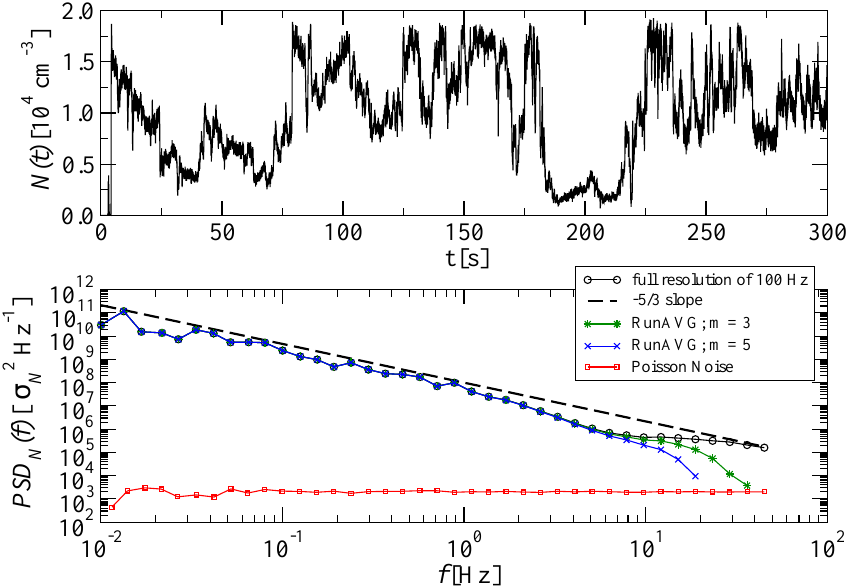
Fig. 10. The upper panel shows a 300-s long time series recorded under undisturbed atmospheric conditions. The FCPC was located about 1ma.g.l. (above ground level). The lower panel shows corresponding power spectral density functions using the full resolution (black curve), a running mean over 3 values (green curve) and a running mean over 5 values (blue curve). The red curve shows the spectral density of Poisson distributed data resulting in white noise (flat line). The black dashed line indicates a − 5/3 slope for inertial subrange scaling.